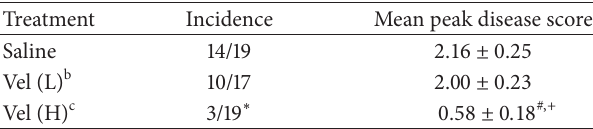
Table 1: Effect of high-dose versus low-dose bortezomib (Velcade) on EAU a